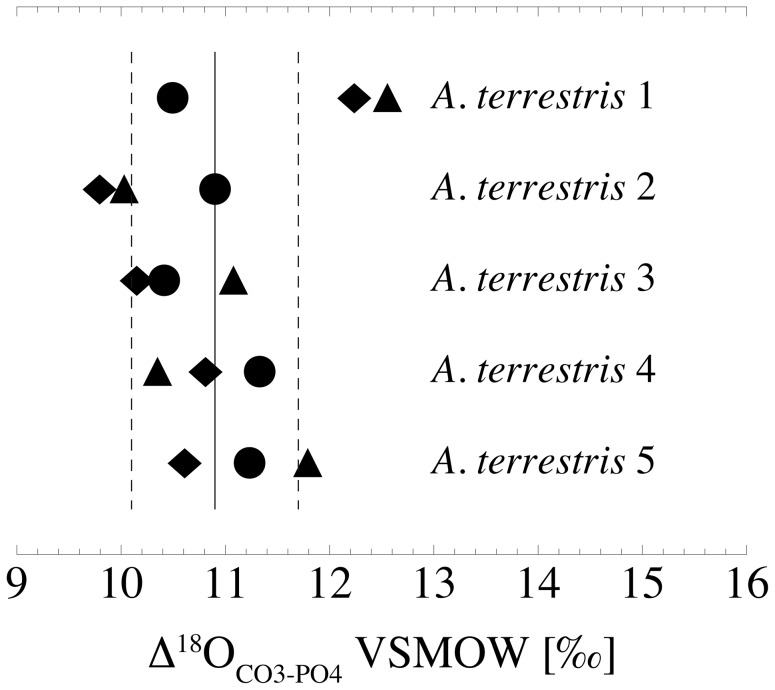
Δ18O CO3-PO4 of incisors, first molars and bone in A. terrestris 1 to 5.Triangles represent the incisors, diamonds the first molars and circles the bones. The average value for all samples is 10.9±0.8‰ (solid and dashed lines).